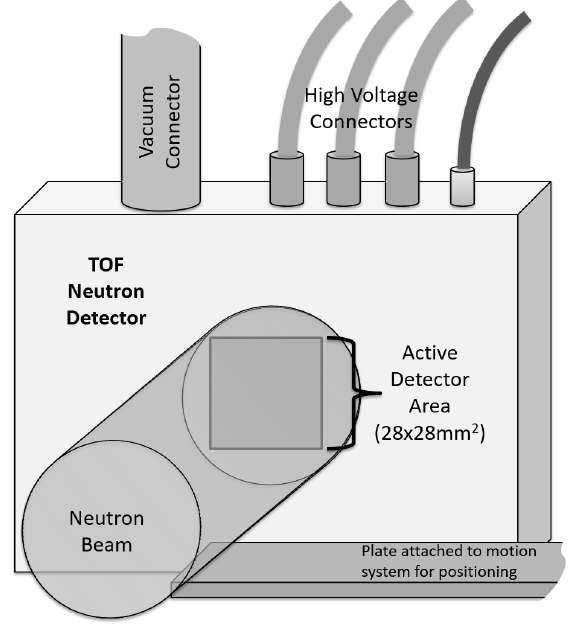
Figure 3 . Detector schematic. Figure 3. Detector